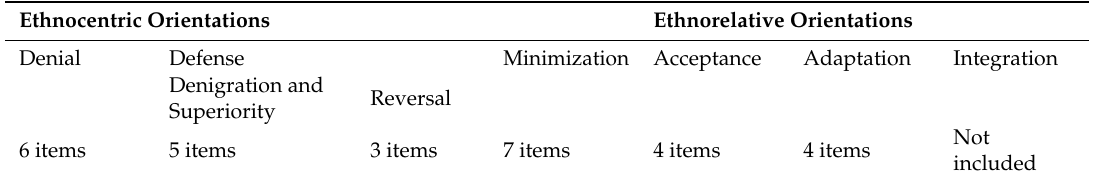
Table 2. Developmental Model of Intercultural Sensitivity, DMIS. (Bennett 1993; Bennett and Bennett 2004). Ethnocentric